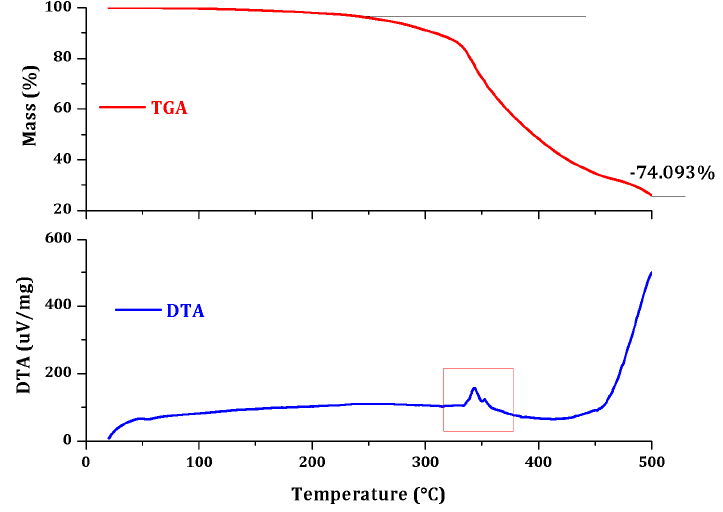
Figure 13. TGA / DTA analysis of the MUF-ENB Figure 13. TGA/DTA analysis of the MUF-ENB system.